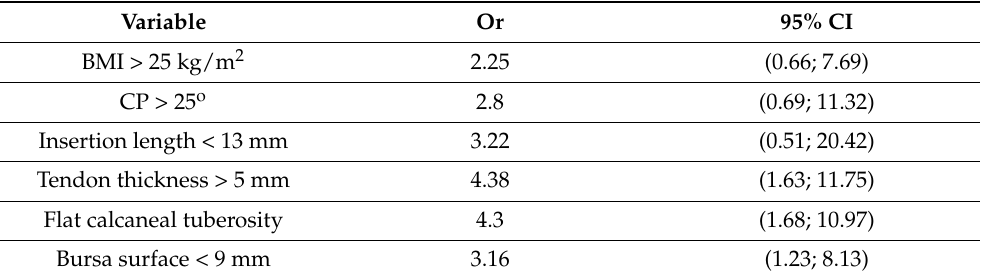
Table 2. The likelihood of occurrence of retrocalcaneal bursitis, depending on the value of the selected feature.